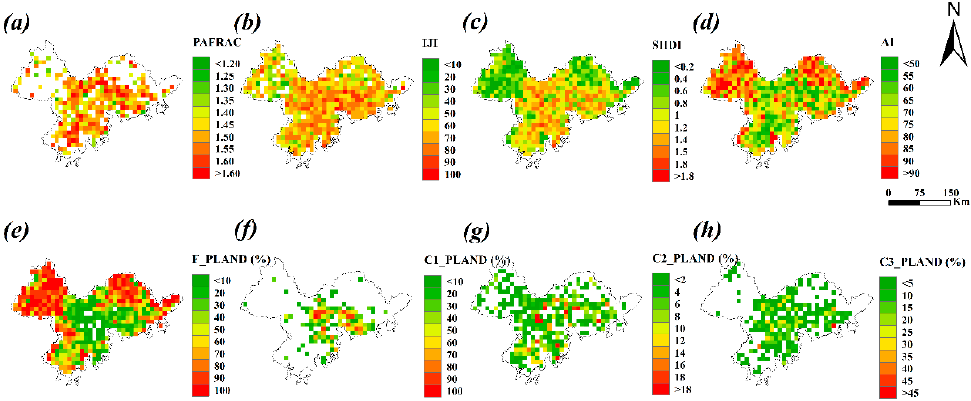
Figure 5. Landscape patterns of ( a ) PAFRAC; ( b ) IJI; ( c ) SHDI; ( d ) AI; ( e ) F_PLAND; ( f ) C1_PLAND; ( g ) C2_PLAND; and ( h ) C3_PLAND in the Pearl River Delta.